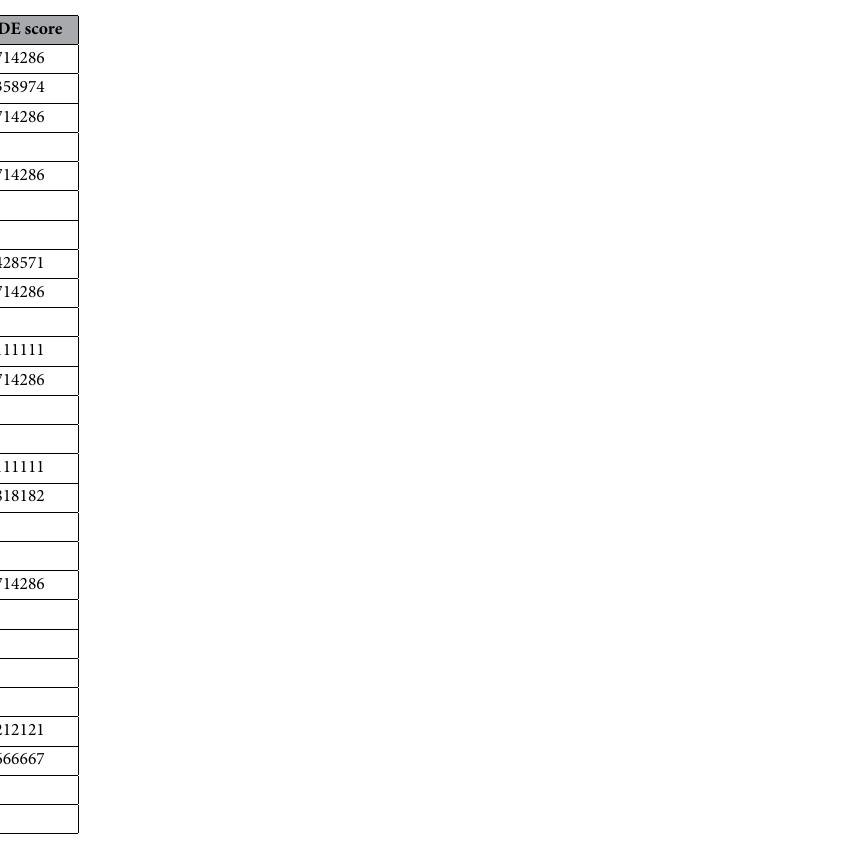
Table 1. The MCODE scores of